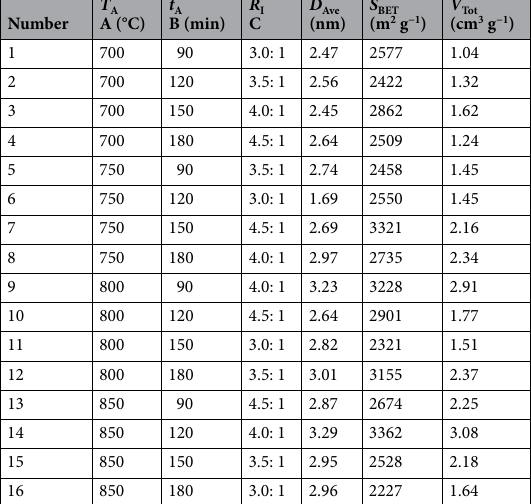
Table 3. Experiment and results of orthogonal design. Where D Ave is the average diameter, S BET is the specific surface area, V Tot is the total pore